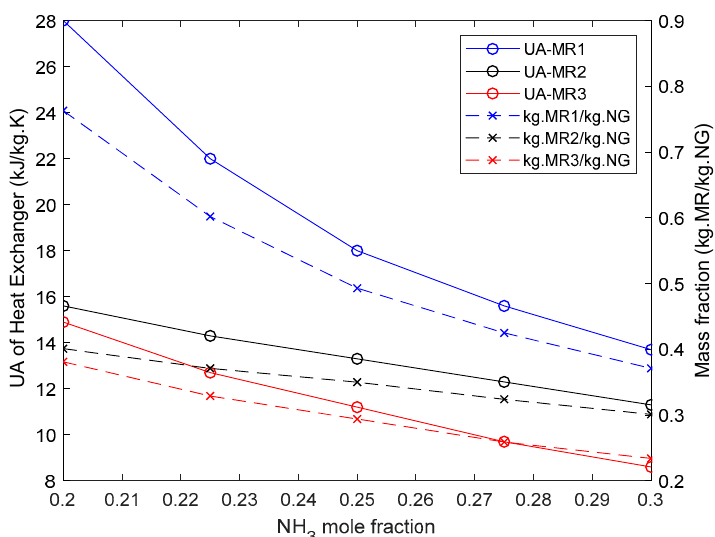
Figure 5. Comparison of heat exchanger UA value for each group of mixed refrigerant, MR-1, MR-2 and MR-3.